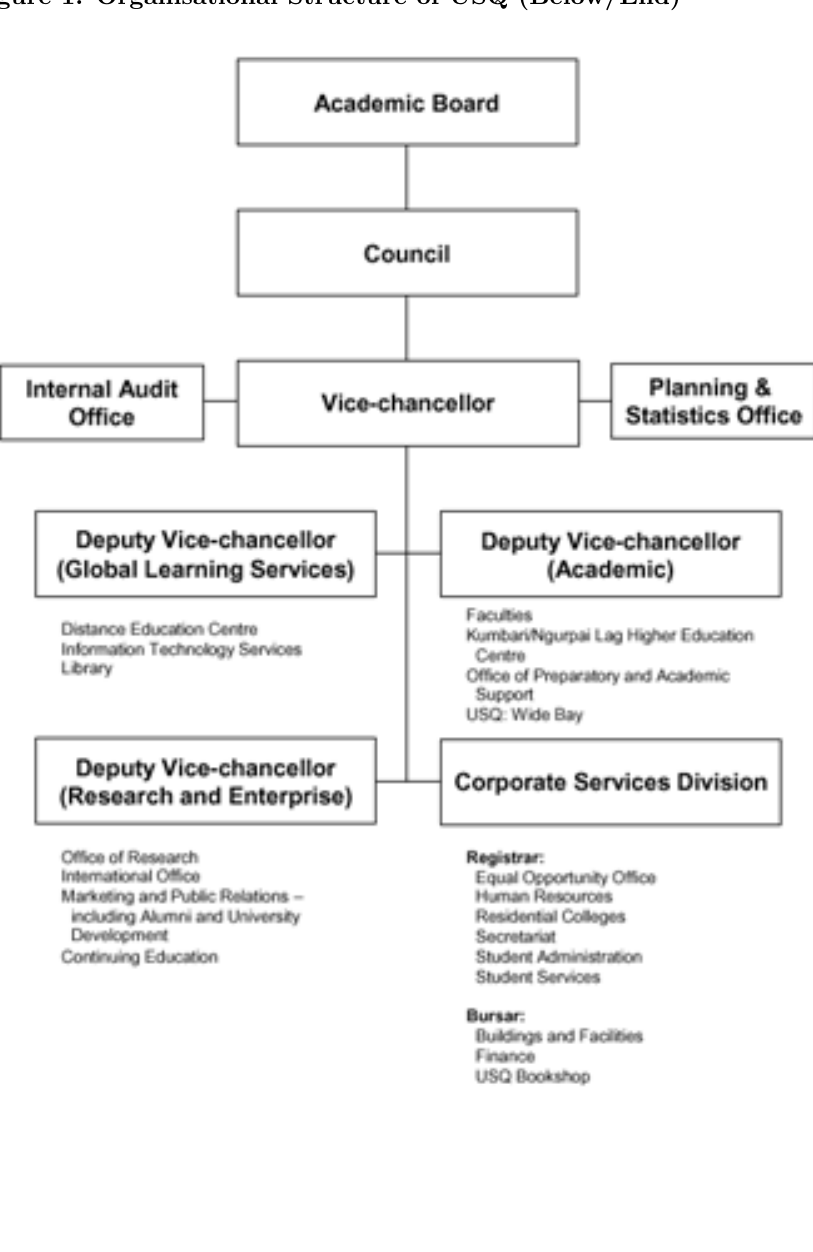
Figure 1: Organisational Structure of USQ (Below/End)